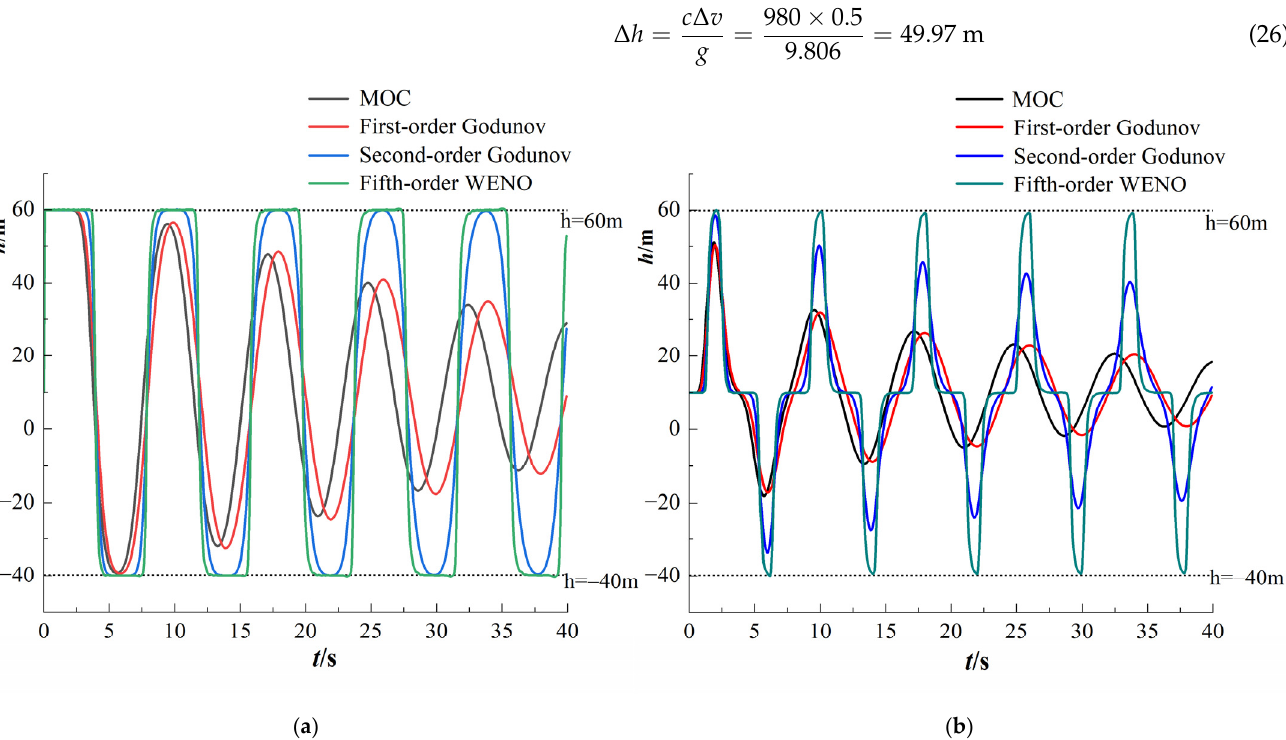
Figure 5. Comparison of results of different schemes for Cr = 0.1. ( a ) Comparison of pressure wave curve at value . ( b ) Comparison of pressure wave curves at 540 m